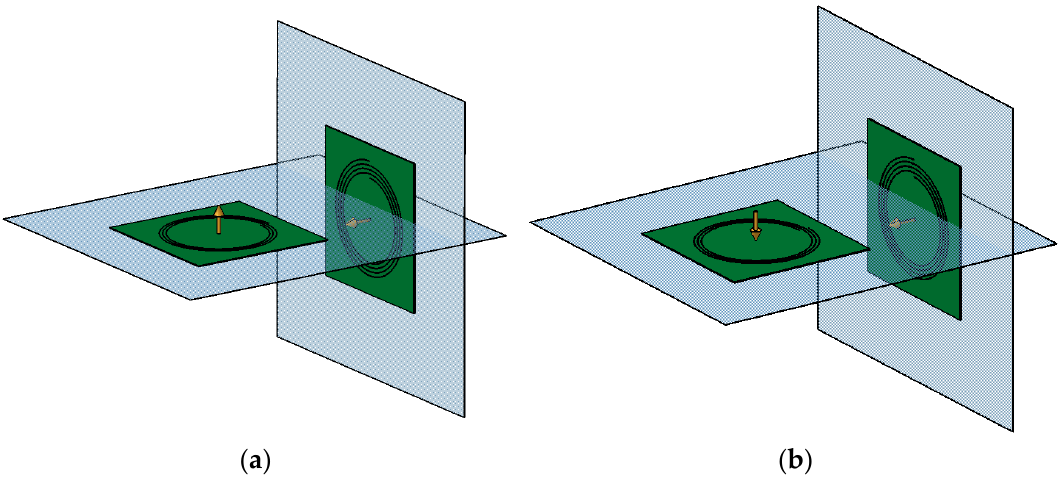
Figure 2. The photograph of the sensor: transmitter ( left ) and receiver ( right ).